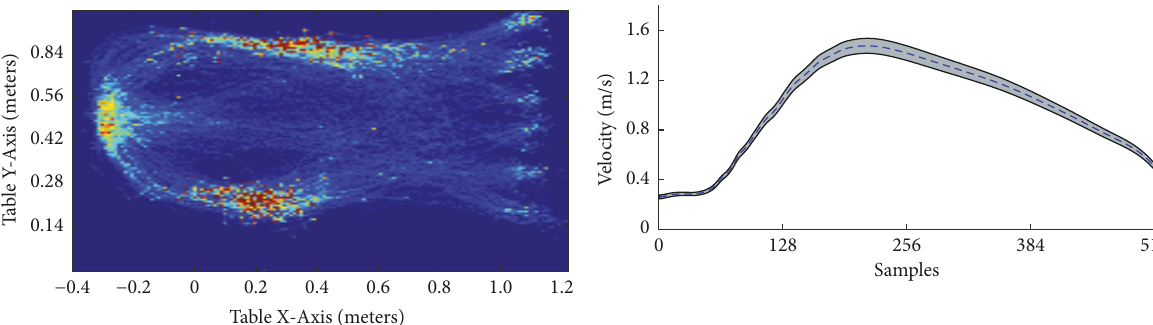
Figure 5: (Left) Heat map of table positions for example pair during Experiment 1 illustrating trajectories during the experimental task. (Right) Average velocity for all participants during the pick-up-to-target subtask trajectory with 95% confidence interval (grey). Velocity time series lengths were normalized to 512